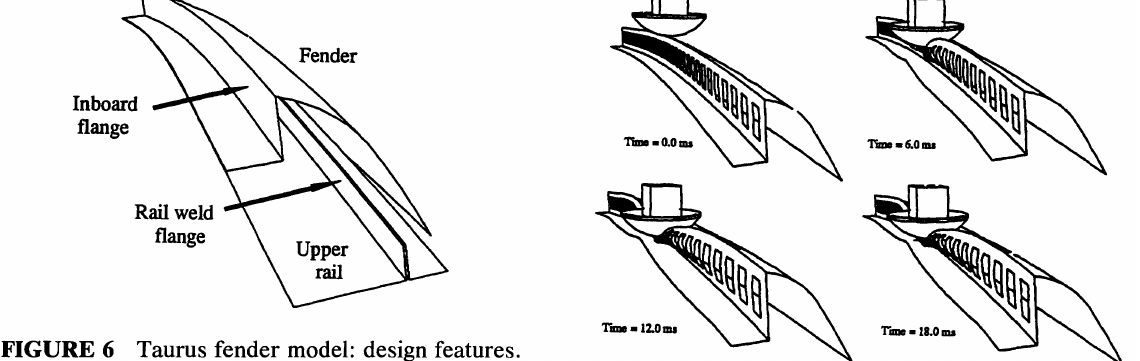
FIGURE 6 Taurus fender model: design features.